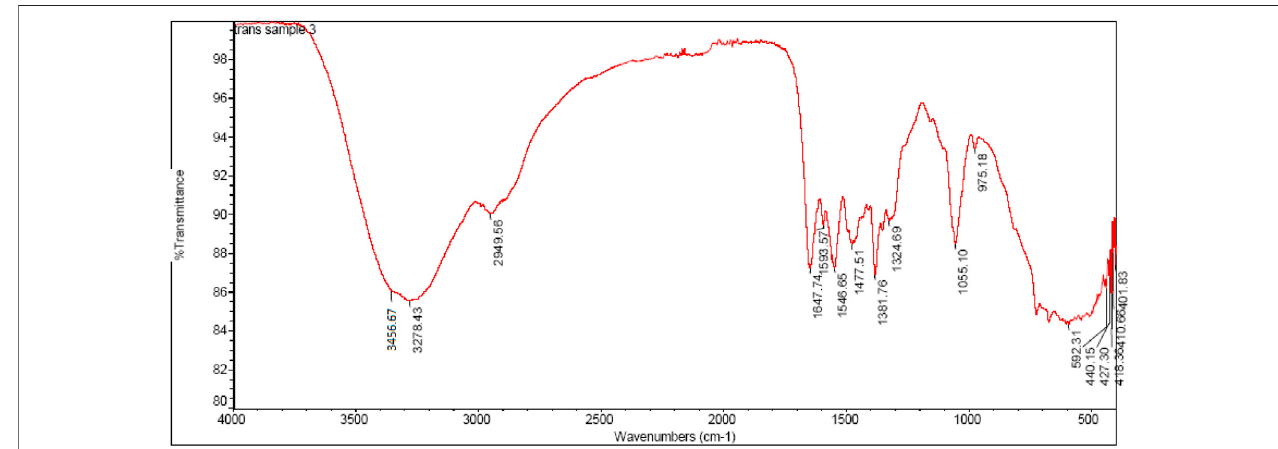
FIGURE 3 | FTIR Spectrum of compound-2h.